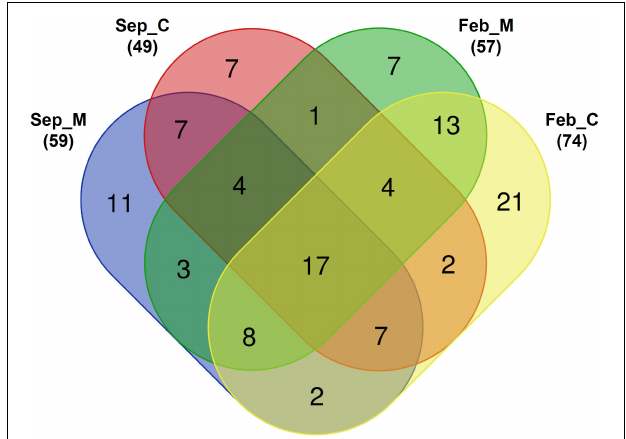
FIGURE 3 | Venn diagram of detected fish species in Korean coastal waters by eDNA metabarcoding analysis [M, aggregate mining; C, control; numbers in parentheses represent total number of identified fish species in each area. Venn diagram was constructed with an online